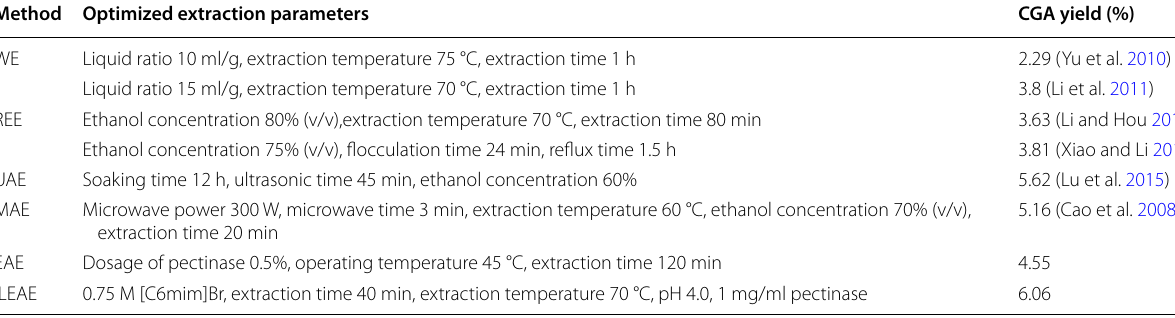
Table 1 Comparison of ILEAE with the reference and conventional methods Method Optimized extraction parameters